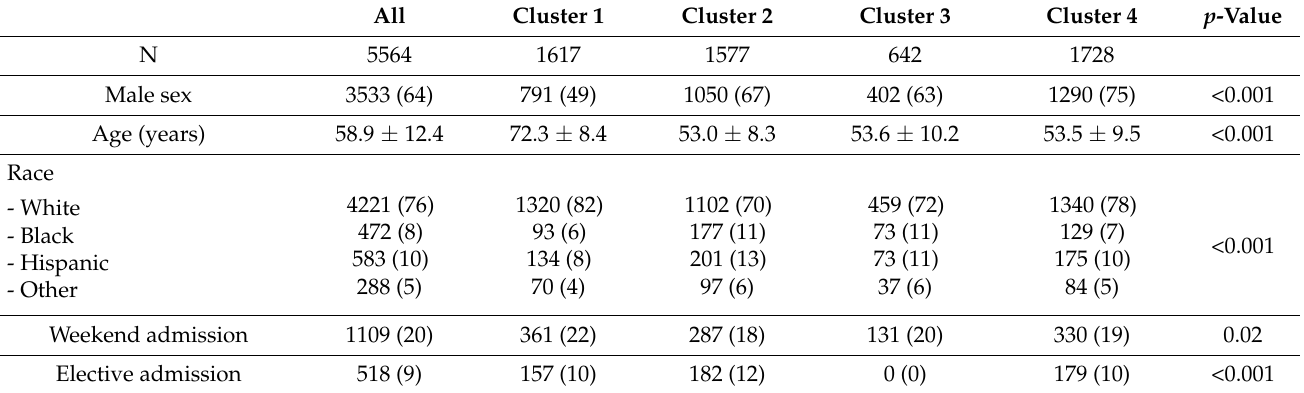
Table 1. Clinical characteristics according to clusters of hepatorenal syndrome